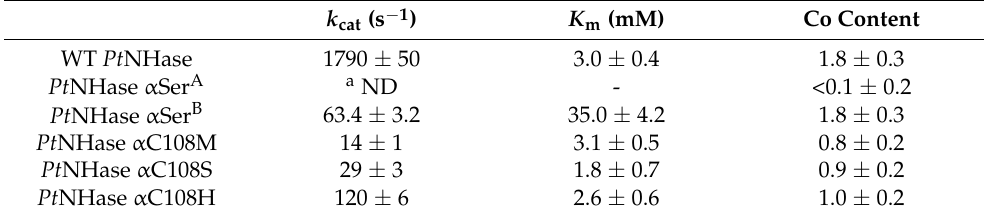
Figure 3. As purified Samples 1 (198 µ M Wt- Pt NHase) 2 (1.1 mM Pt NHase α Ser A ), and and 3 (247 µ M Table 1. Kinetic constants ( k cat and K m ) using acrylonitrile as substrate at pH 7.5 for WT Pt NHase and active-site mutants.